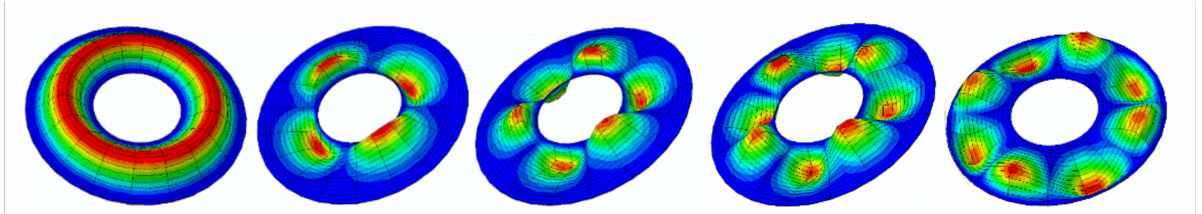
Figure 5. Forms of the buckling modes for a plate with thermal